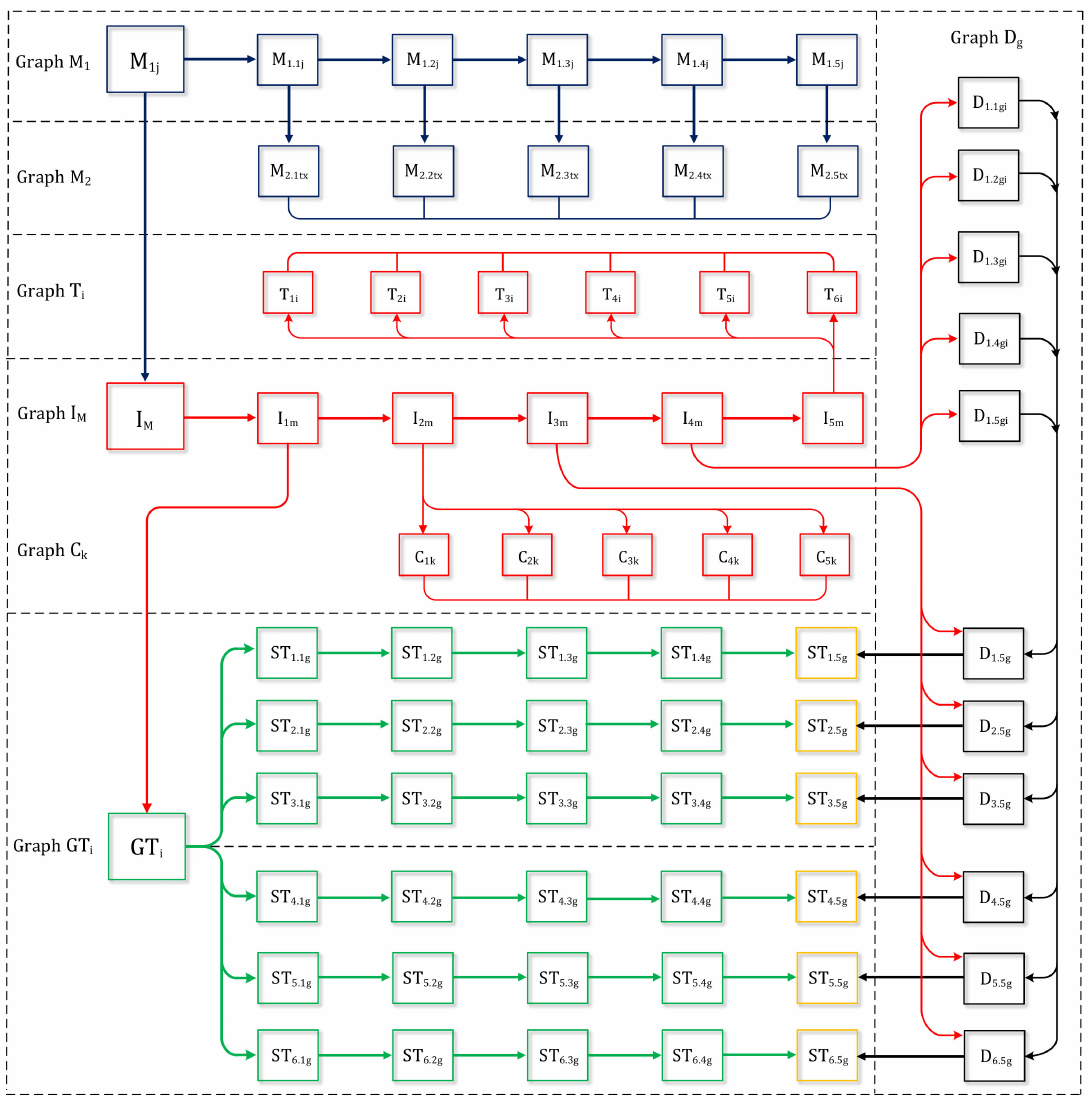
Figure 9. Formal model of “Cyberattack threat/TDTN protection system/Cyberattack